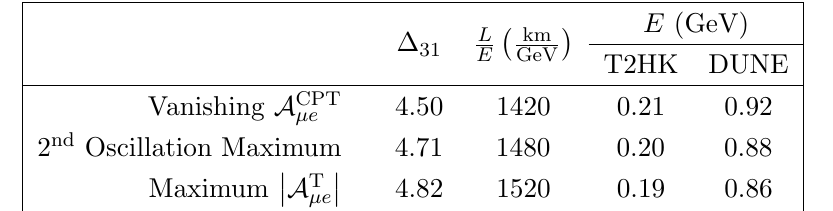
Table 2 . Speci(cid:12)c position of the (cid:12)rst zero (cid:1) CPT